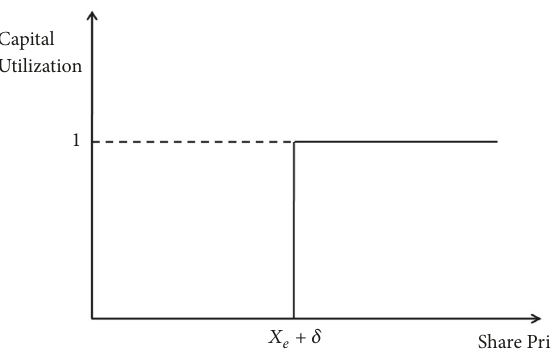
Figure 3: Capital utilization function with linear position strategy when 𝛽 = 𝛽 0 = 1